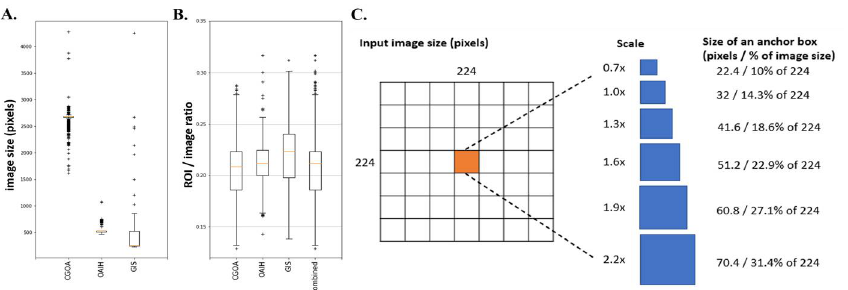
Figure 3. Comparison of three radiographic dataset distributions and generation of anchor boxes. ( A ) The image size distributions of the three datasets. ( B ) The distributions of three datasets. ( C ) Generation of anchor boxes for the one feature layer of the customized SSD head structure. With an input square image with 224 × 224 pixels, there are 7 × 7 grid cells with 32 × 32 pixels with scale = 1, and each grid cell can use different scale parameters to generate various sizes of anchor boxes covering 10% to 31.4% of the input image size, depending on the training image size distributions. We specified the input image size of 224 × 224 pixels split by 7 × 7 grid cells, where each grid cell is of size 32 × 32 pixels. We set 6 equally spaced scales parameters {0.7, 1.0,